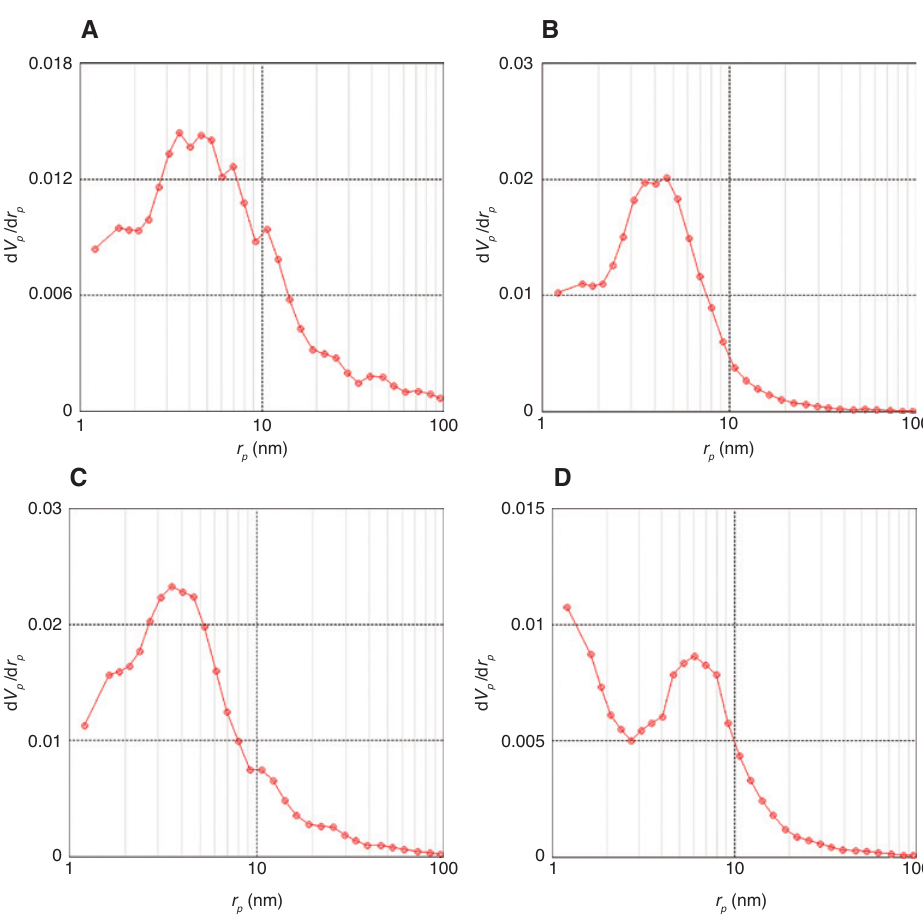
Figure 3: Pore-size distribution of materials A: (A) MgO-0, (B) MgO-1, (C) MgO-2, (D) MgO-3.